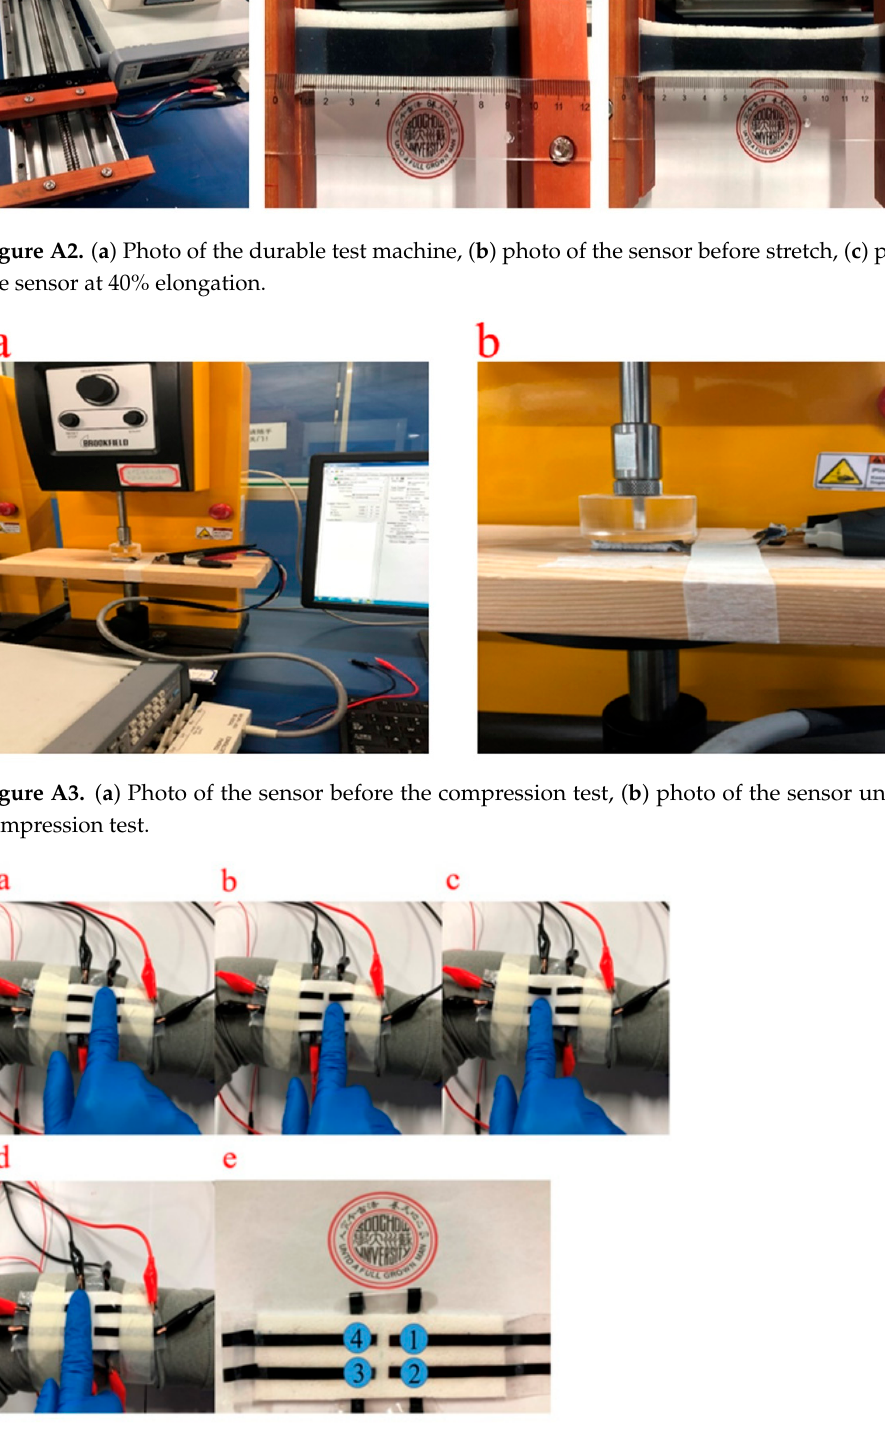
Figure A4. ( a – d ) Photos of the test when we touch the sensor. ( e ) Photo of the sensor we